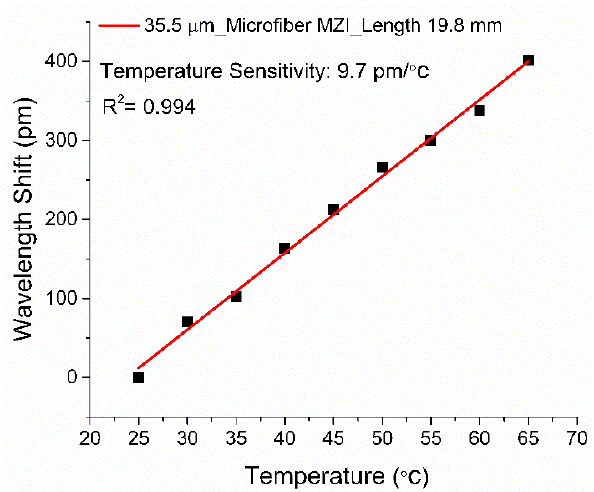
Figure 9. Temperature characterization of the microfiber MZI RI sensor with a TWD of 35.5 µm.